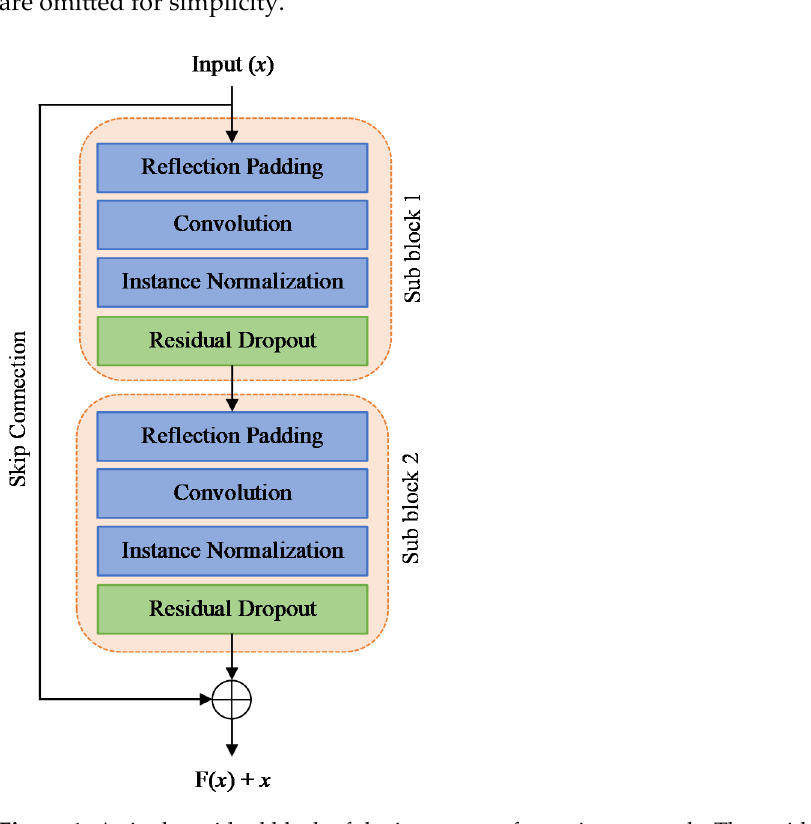
Figure 1. A single residual block of the image transformation network. The residual dropout regu‑ larization layer is added after the instance normalization layer at each sub‑residual block.